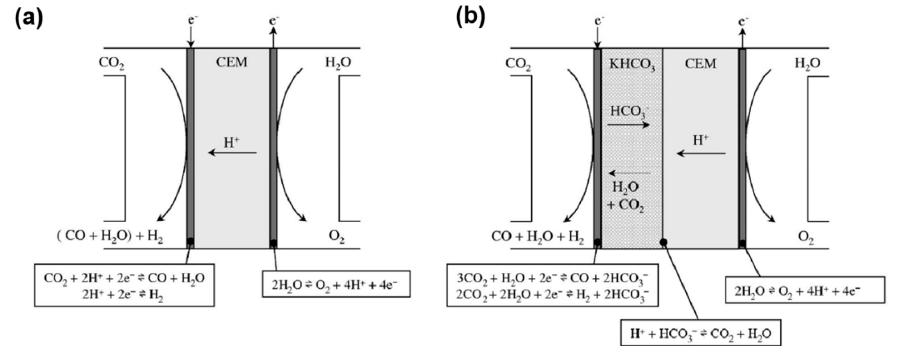
Figure 9. The schematics for MEA cells adopting a cation-exchange membrane ( a ) without and ( b ) with the KHCO 3 buffer layer. Reprinted with permission from the authors of [55].